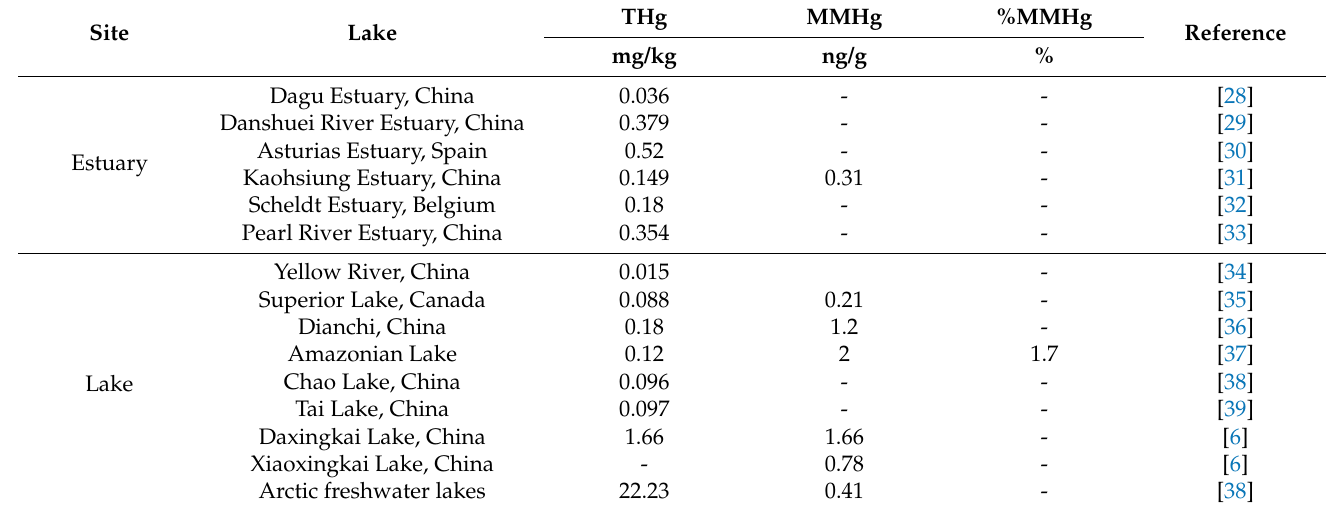
Table 1. Comparation of estuary and lake sediment in Nansi Lake and other